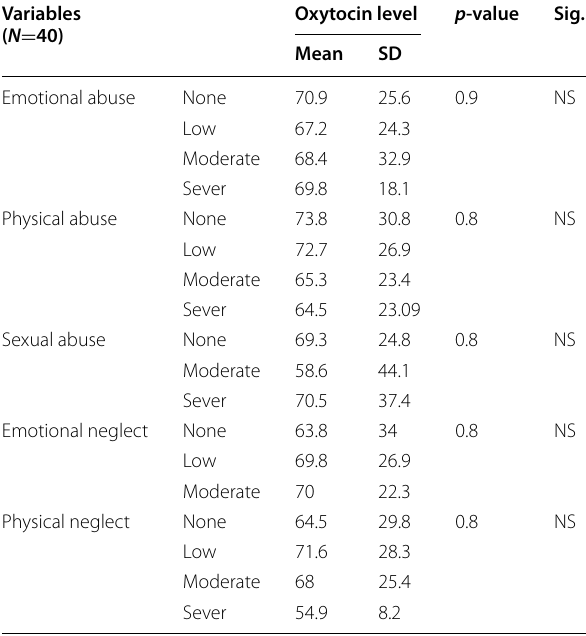
Table 4 Correlation between oxytocin level and temperament and character inventory - revised (TCI-R)